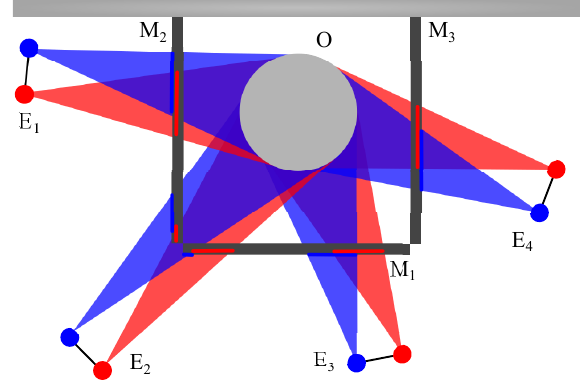
Sketch of four stereoscopic projections depending on the user’s position: M 1 ; 2 ; 3 are three stereoscopic monitors, E 1 ; 2 ; 3 ; 4 are four different possible positions of the user’s eyes, O is the virtual object being displayed, and the red and blue triangles represent the stereoscopic projections of the same virtual object for each user’s position.